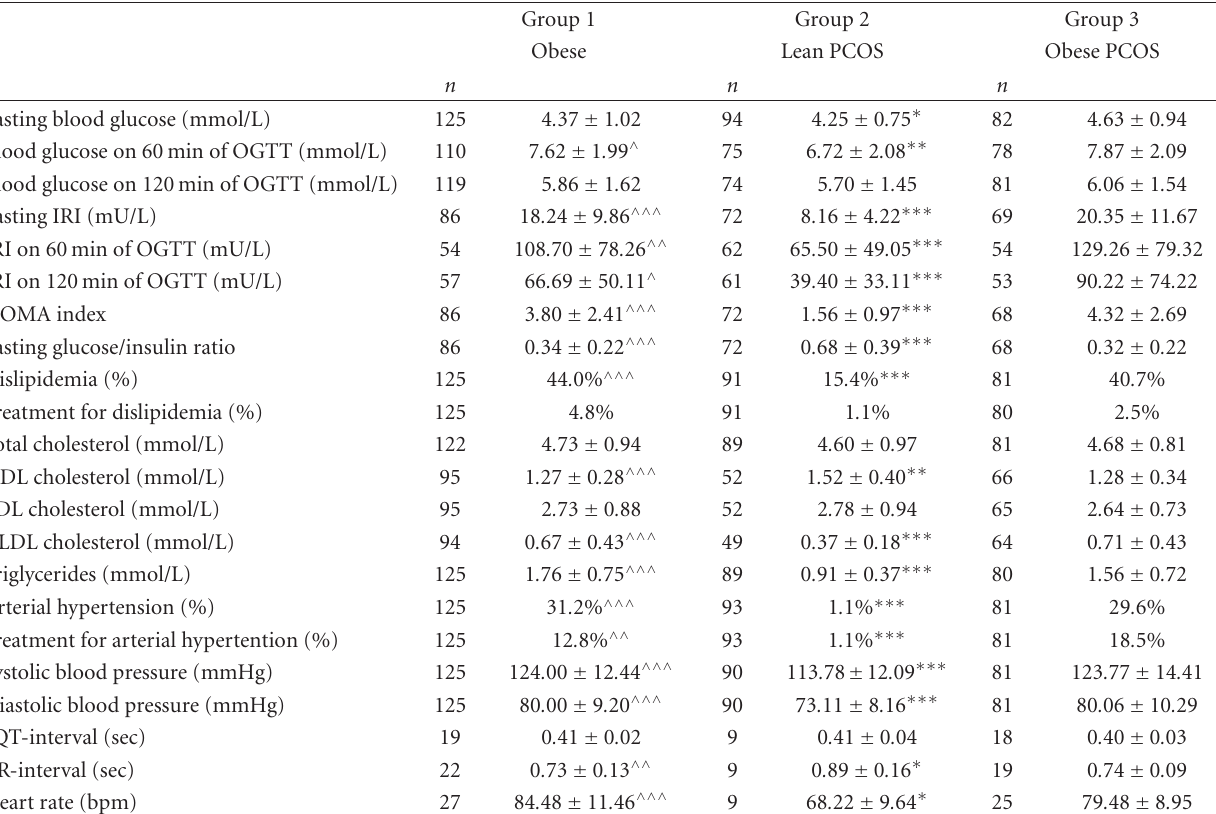
Table 2: Comparison between the results from oral glucose tolerance test, lipid profile, blood pressure measurement, and ECG characteristics between the three